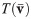
Reprinted from [Fig 4] under a CC BY license, with permission from [SUTC], original copyright [2018].Distribution of total system travel time in Shenzhen. Fig 4 (A) displays T(v-) without tolls (h), and Fig 4 (B) displays T(v^) with differentiable tolls (h).